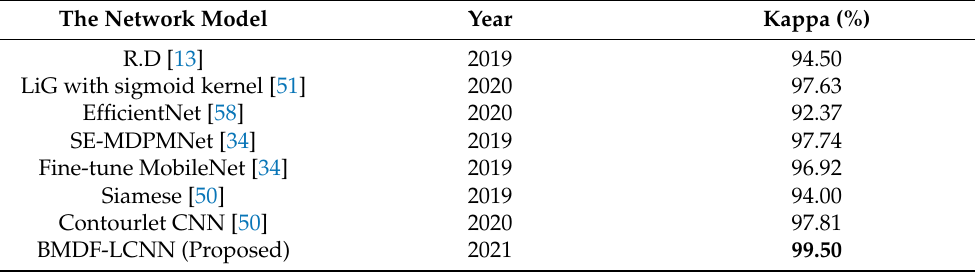
Table 3. Comparing the Kappa values of the proposed model with some advanced methods on the UC dataset.